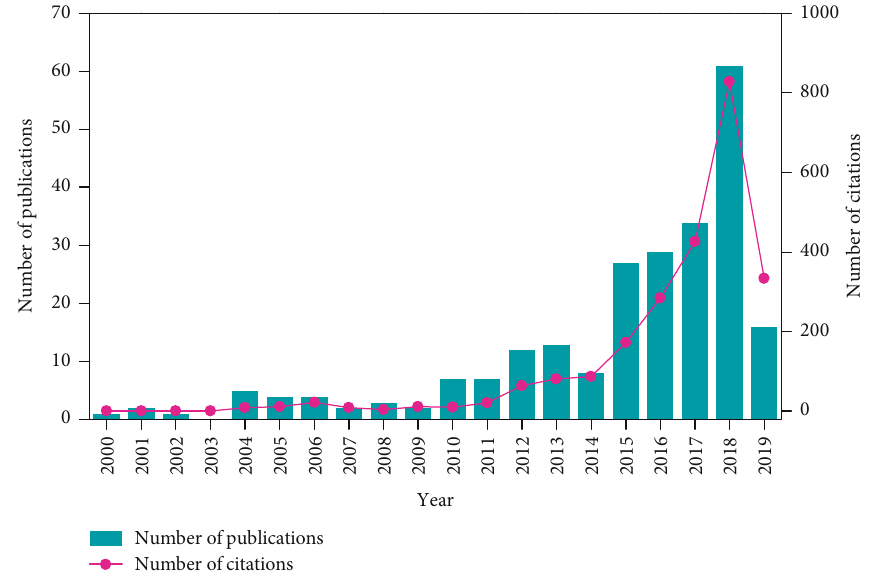
Figure 5: Number of publications and citations of China from 2000 to 2019.